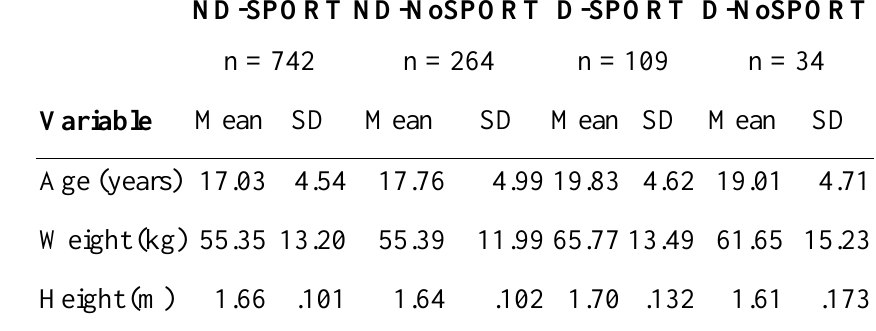
Table 1 Description of the sample (age, weight, height)